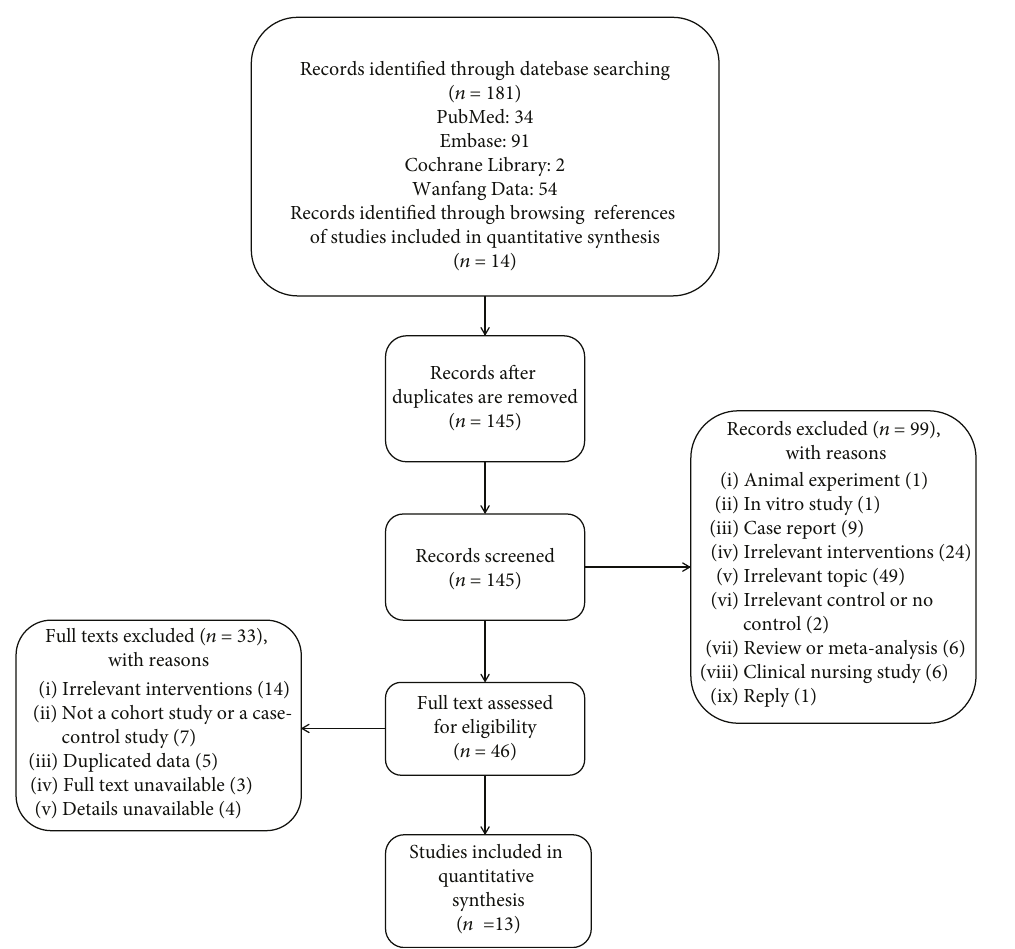
Figure 1: Flow diagram of trial